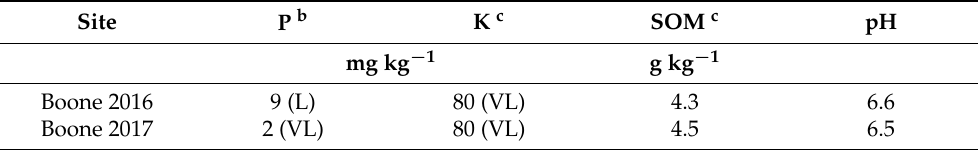
Table 2. Baseline soil test values (0–15 cm) and soil information for study site at Boone, IA, USA